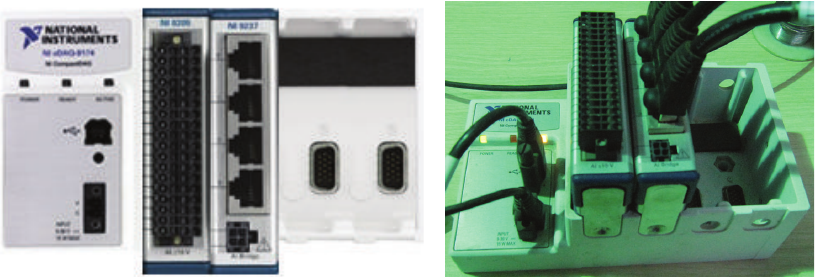
Figure 7: Data acquisition system of NI.